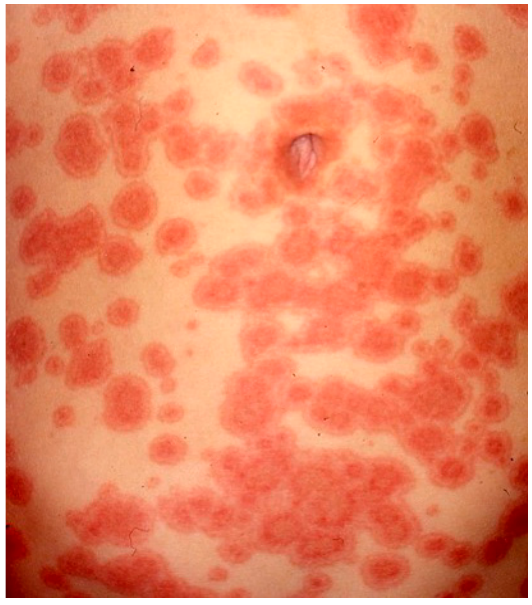
Figure 9. Abdominal multiple target lesions due to erythema multiforme.